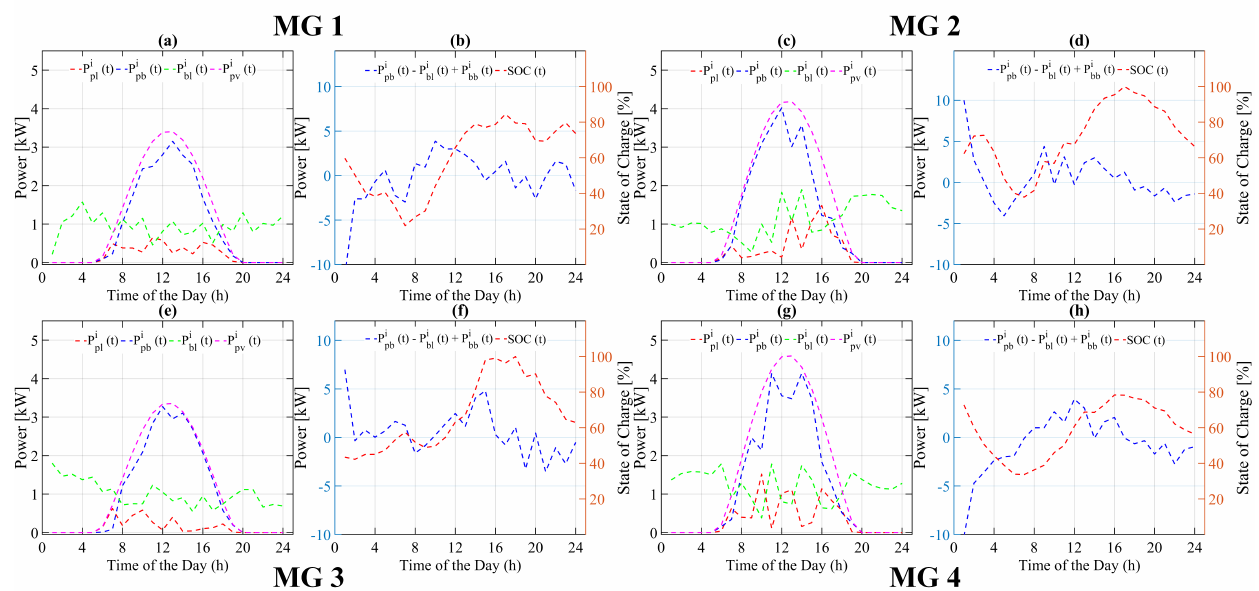
Figure 7. Power flow of various system variable of each microgrid using proposed optimization based energy management strategy for case A. ( a , c , e , g ) Power flow of PV, battery and Load, ( b , d , f , h ) Battery charging/discharging and state of